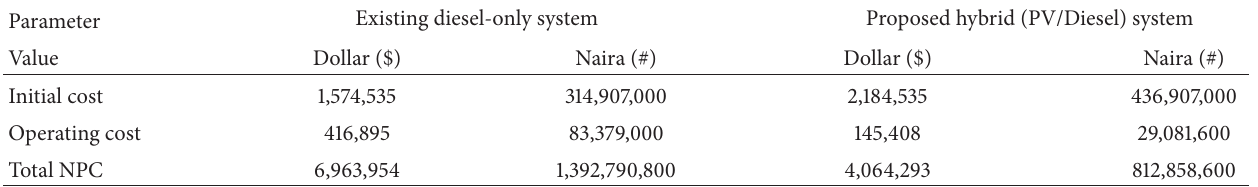
Table 7: Comparison simulation of economic results between existing system and a hybrid